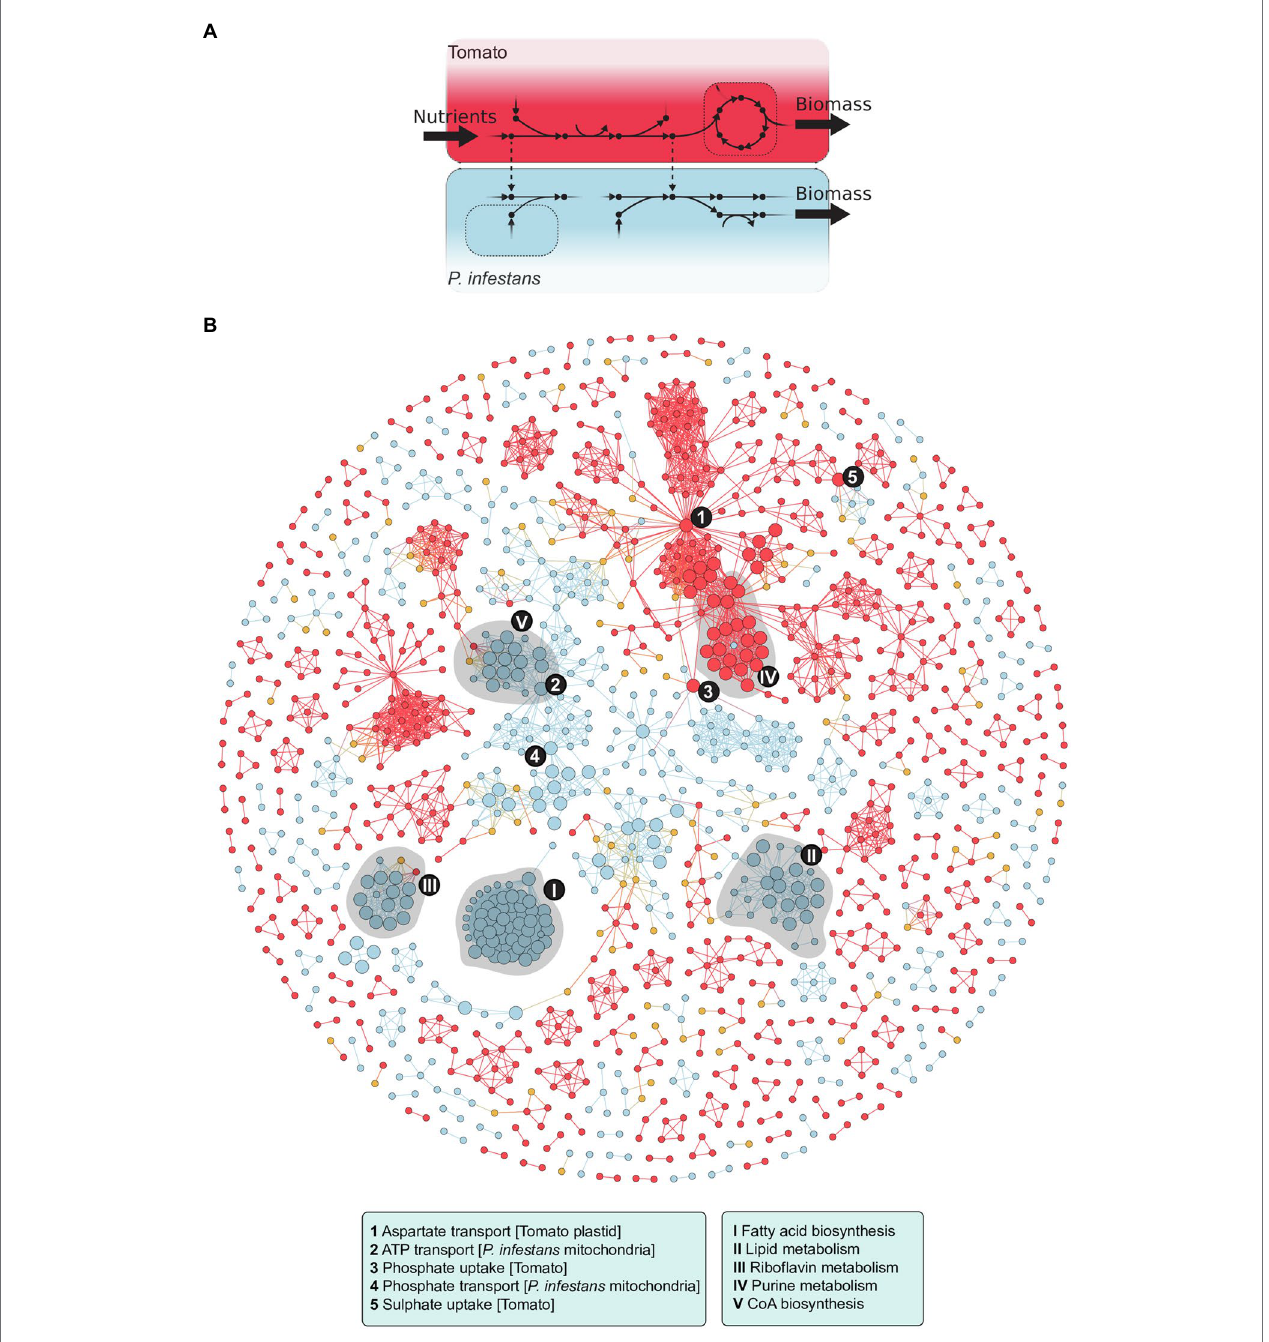
FIGURE 2 | The integrated P. infestans –tomato model (reproduced and adapted from Rodenburg et al., 2019). (A) Diagram in which dots represent metabolites, arrows reactions, and dotted lines host–pathogen transport reactions. (B) Flux coupling analyses of the model identified 77 coupled (i.e., topographically related) P. infestans –tomato reaction pairs which are shown in the graph. Nodes represent reactions in tomato (red) or P. infestans (blue) and host–pathogen transport (yellow). Edges represent coupling between those reactions. The nodes with the largest diameter represent 112 reactions in P. infestans and 35 in tomato that were found to be essential for P. infestans biomass production. The various processes listed in the boxes are represented by highly connected nodes (1 to 5) and in shaded clusters (I to V). Further details in Rodenburg et al.